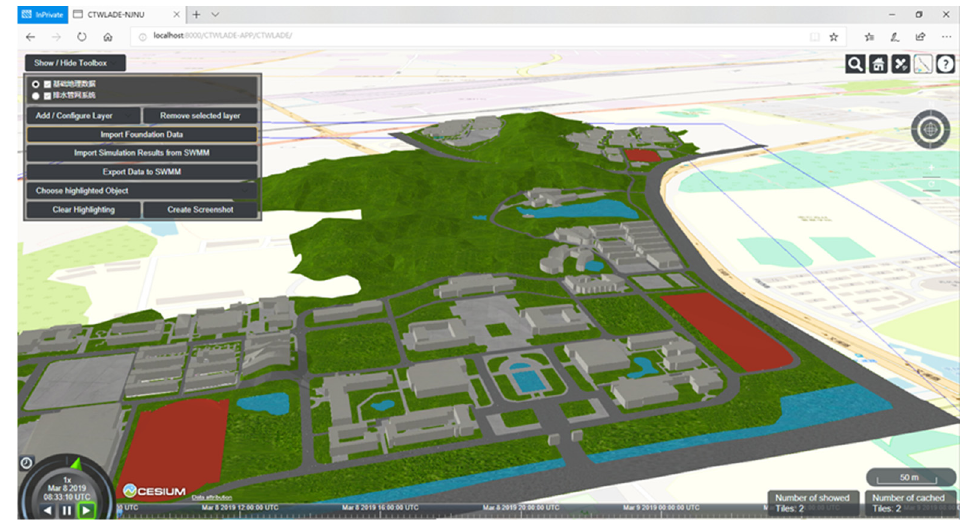
Figure 17. 3D virtual environment of research area generated based on city waterlogging application domain extension (CTWLADE) data. ISPRS Int. J. Geo-Inf. 2020 , 9 , x FOR PEER REVIEW